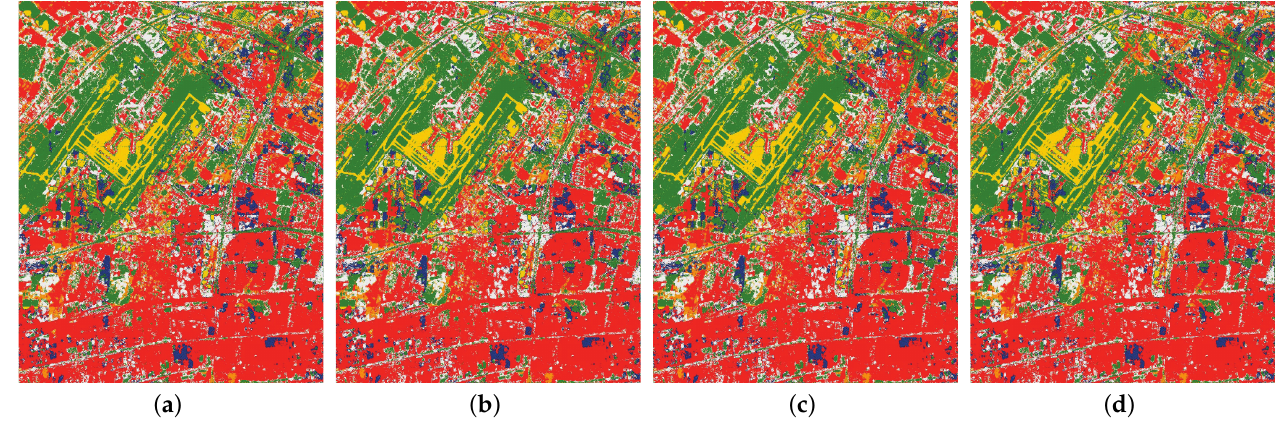
Figure A11. Classification results with different distance thresholds. ( a ) Result with distance thresh- old 0.5%. ( b ) Result with distance threshold 1.0%. ( c ) Result with distance threshold 1.5%. ( d ) Result with distance threshold